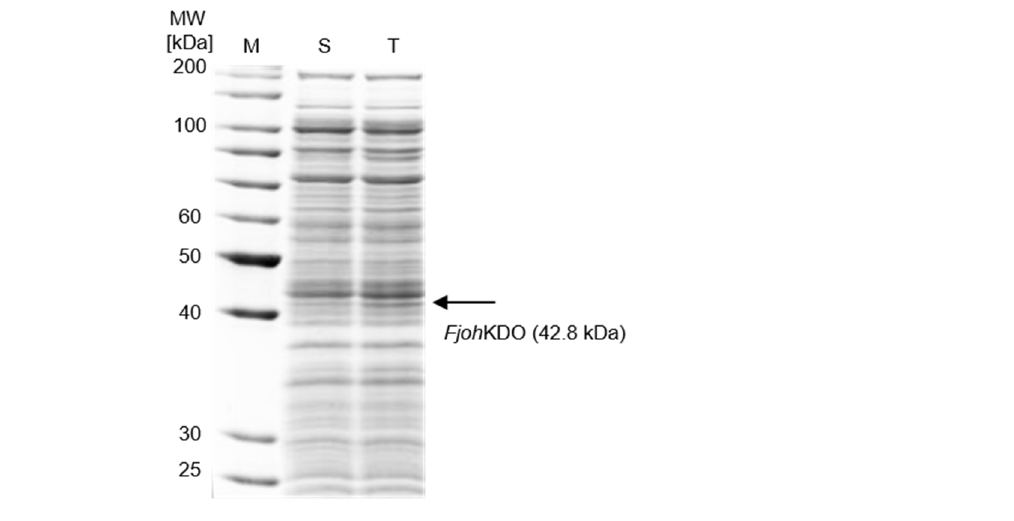
Figure 5. Exemplary SDS-PAGE gel image of cell-free synthesized KDO from Flavobacterium johnsoniae ( Fjoh KDO). M, marker; T, total protein; S, soluble protein fraction (obtained through centrifugation for 10 min at 18,000 × g ). Table 1. Hyl concentrations in mM achieved in in vitro hydroxylation assays for cell-free synthesized KDOs with chaperone-enriched cell extracts. Assays were performed on a 100 µ L scale with 10 mM Lys and 20% v/v protein solution for 20 h. Coloring applies to each row individually; dark green is the highest value and red is the lowest value. Values below 0.02 mM are dark red. Standard deviations are a result of biological